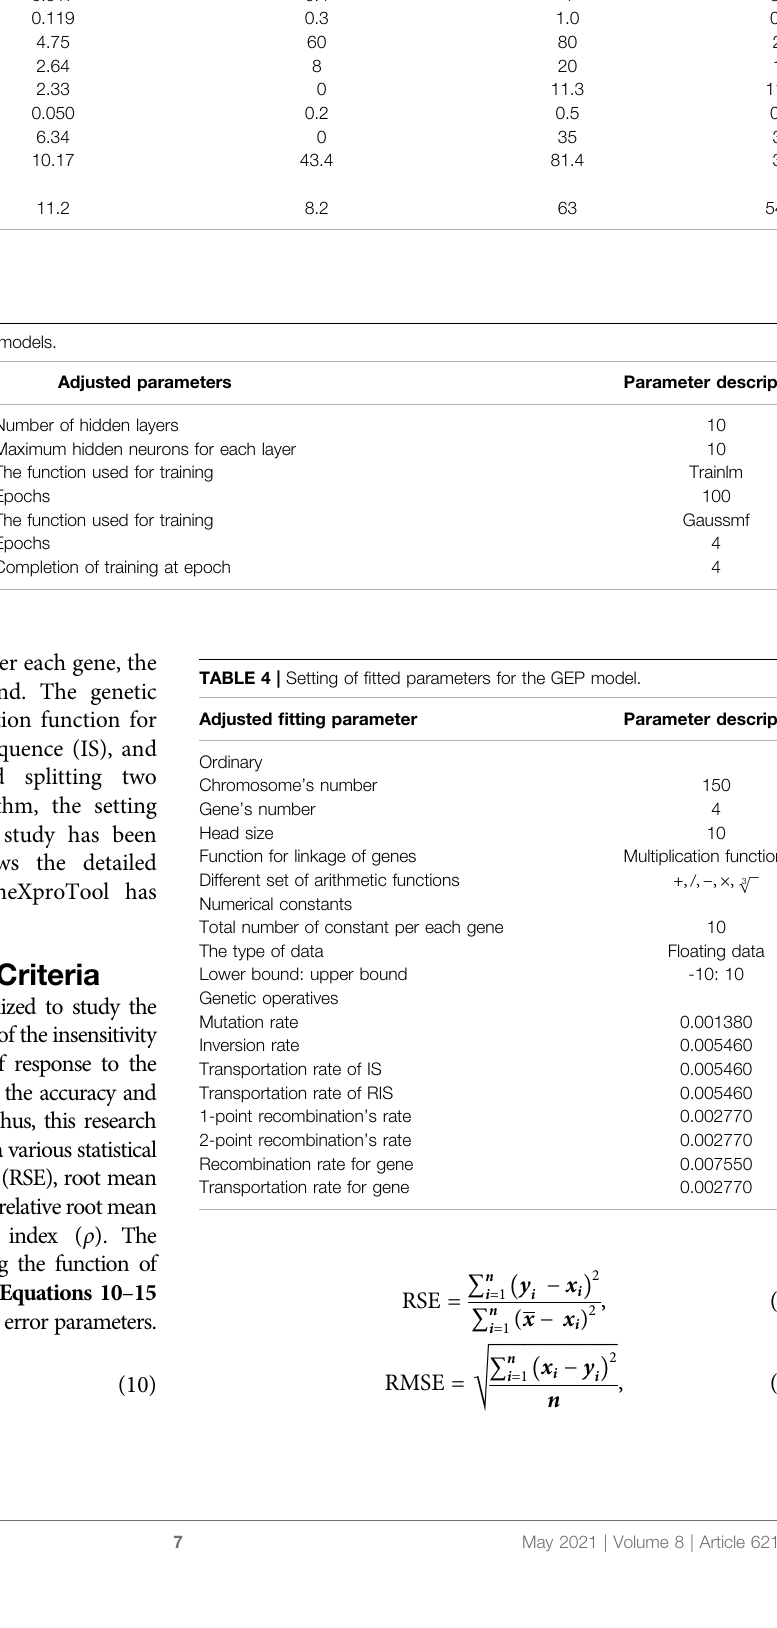
TABLE 2 | Mean value, standard deviation, and range of input and targeted parameters. Parameter